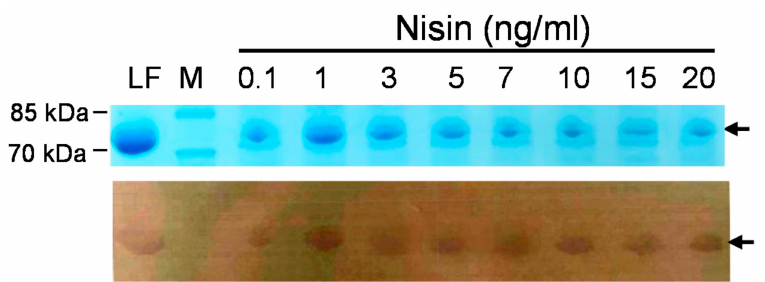
Figure 4. Influence of varying concentrations of nisin on recombinant lactoferrin expression. The Lactobacillus gasseri /BLF was induced using eight doses of nisin for 6 h, and the cell lysates were harvested and subjected to SDS-PAGE analysis (top panel) and Western blotting analysis (bottom panel). Lane LF: control well of 0.32 µ g standard bovine lactoferrin (80 kDa); M: molecular weight marker; arrow indicates target